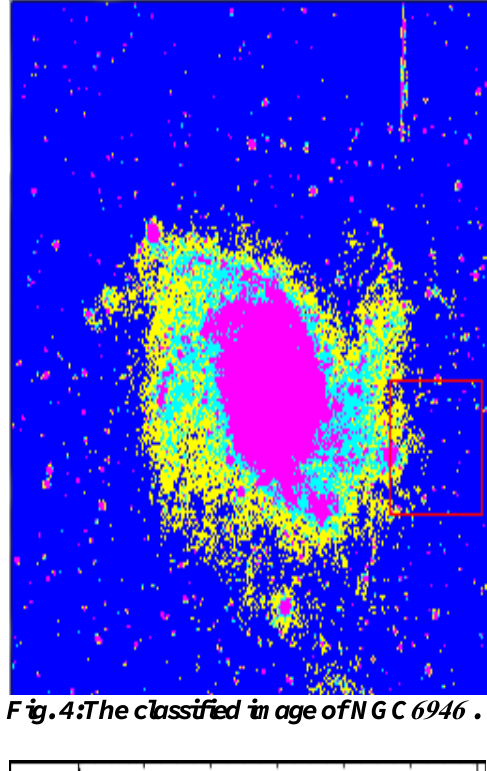
Fig. 2: Multiband image of NGC 6946.